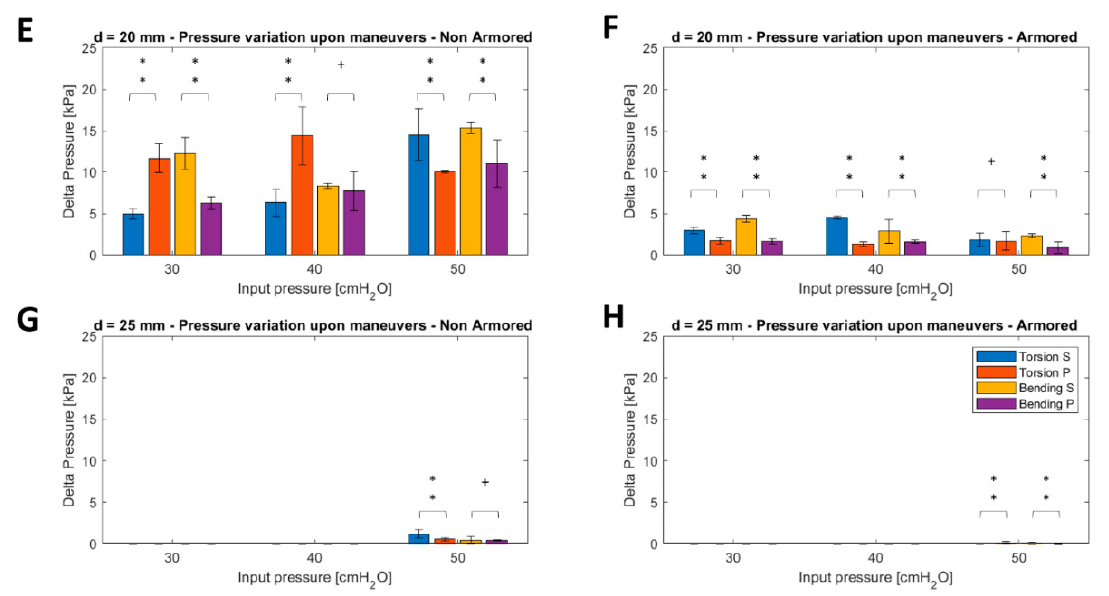
Figure 5. Statistical analysis to determine the differences in pressure variations, if any, after performing a maneuver. ( A – D ) Histograms showing a comparison between non-armored (NA) and armored (A) tubes across diameters of the trachea and position (S—supine, P—prone). ( E – H ) Histograms showing the comparison between body position (S/P) across diameters and type of endotracheal tube (NA/A). Legend: ** p < 0.001, * 0.002 < p ≤ 0.05, and + p > 0.05.